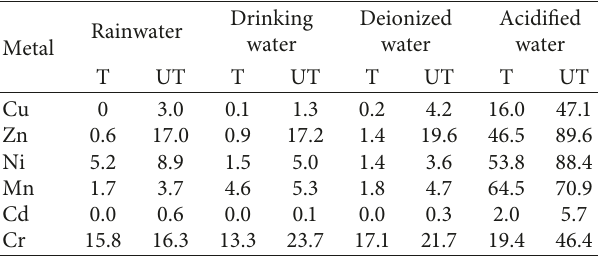
Drinking Deionized Acidified water water